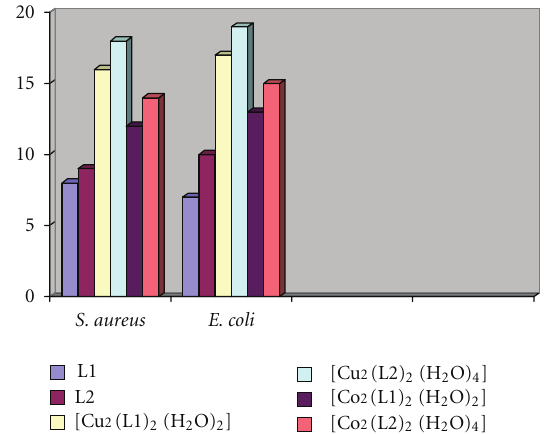
Figure 4: The e ff ect of ligands and their metal complexes toward